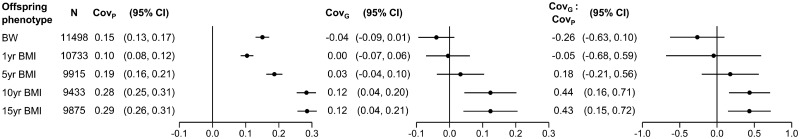
Estimates of phenotypic covariance (CovP), genetic covariance (CovG) and the ratio of CovG to CovP, between maternal BMI and offspring phenotype, from the combined cohorts (pooled IPD estimates). All variables were standardized to give mean zero and variance one in the combined cohorts, therefore phenotypic covariances are equivalent to Pearson correlation coefficients. If CovG and CovE (the residual covariance) are opposite in sign then CovG:CovP may be negative or >1; in this case CovG:CovP cannot be interpreted as a proportion, but still gives an indication of the extent to which phenotypic covariance is explained by genotype. BW, birth weight, BMI, body mass index.